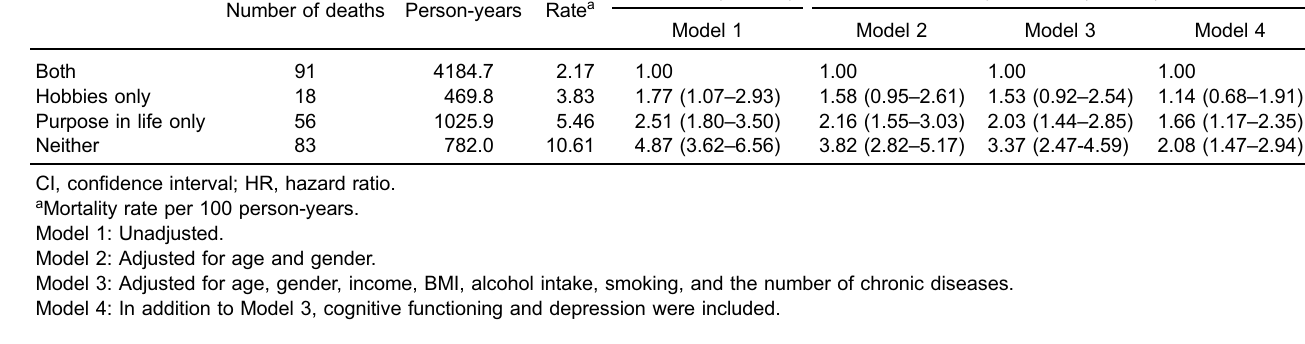
Table 3. Results from logistic regression models of association between hobbies, a purpose in life ( ikigai ), and a decline in ADL or IADL Outcome Decline in ADL ( n = 1254) Both